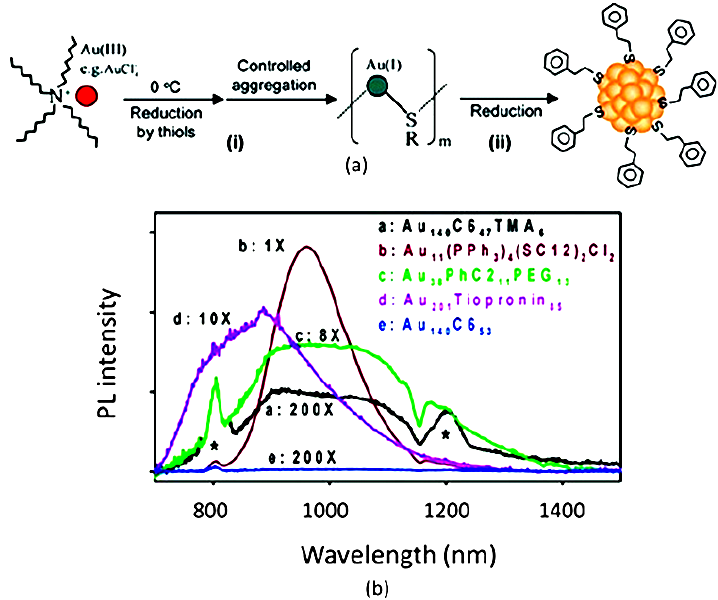
Figure 1. ( a ) Scheme of synthesis of AuNCs. Adapted with permission from Ref. [32]. Copyright 2008 American Chemical Society. ( b ) Comparison between spectra of AuNCs functionalized with different molecules. * Artifacts from second and third-order excitation peaks (800 and 1200 nm). Adapted with permission from Ref. [36]. Copyright 2005 American Chemical Society.